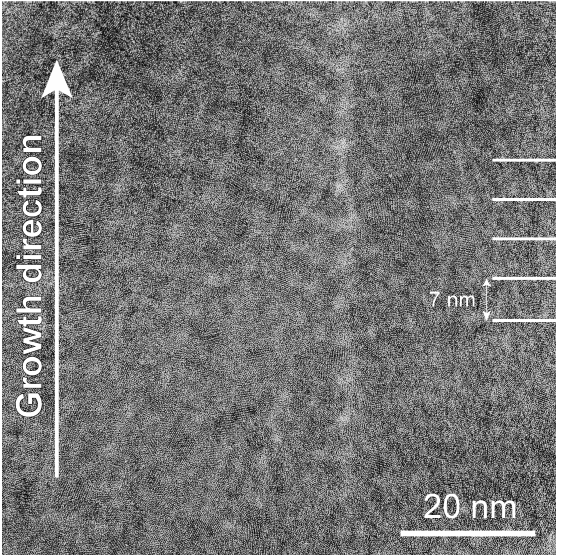
Figure 7. TEM image of the cross-section of a rotating sample with 29 at.% of Ta, 36 at.% of B and 35 at.% of C with apparent multilayered